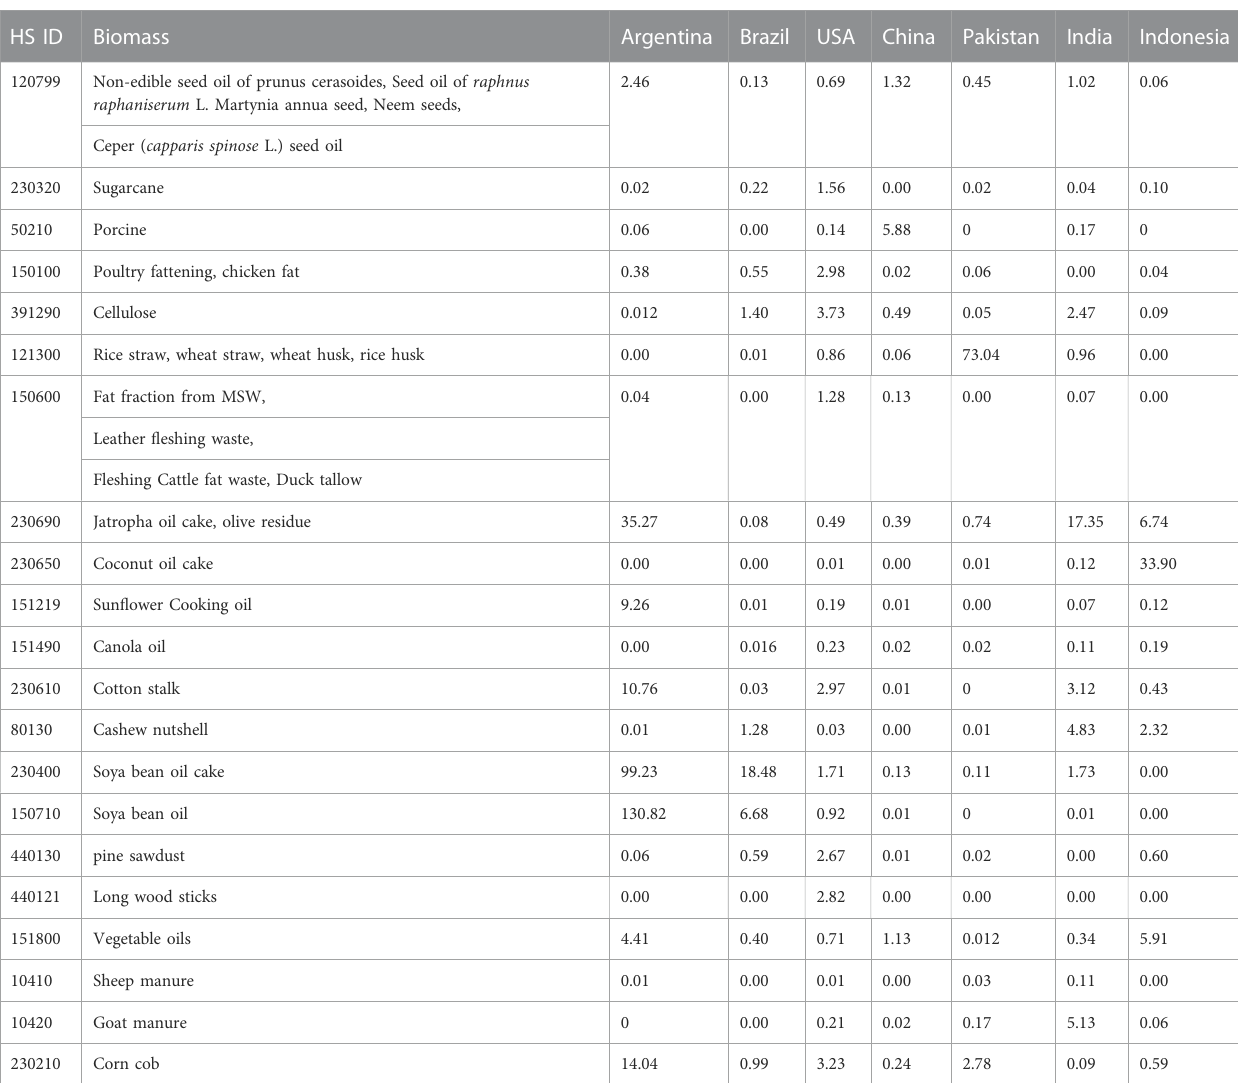
TABLE 5 RCA values of Biowastes for studied countries. HS ID